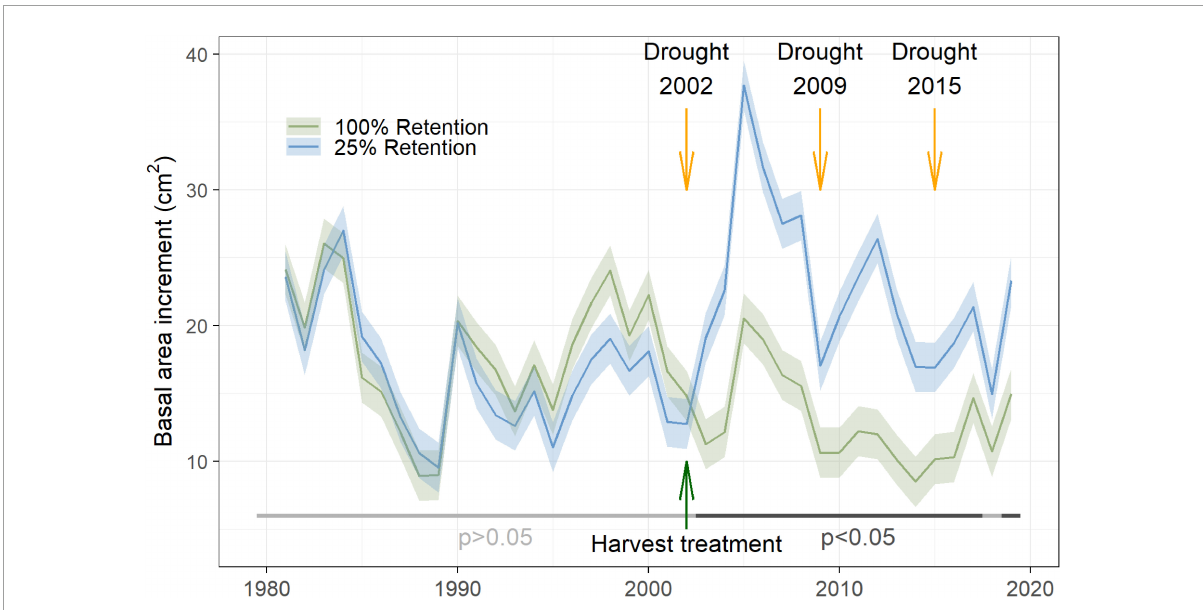
FIGURE4 Timeseries of basal area increments for the no-harvest control (100% retention) and the harvest treatment (25% retention) from 1980 to 2019. The standard error of the mean is indicated with shaded ribbons. A green arrow indicates the harvest year in winter of 2002/2003. Three drought years shortly before (2002), and after the tree removal treatment (2009 and 2015) are indicated with orange arrows. Non-significance of differences in basal area increments is shown by a horizontal line in light grey, while a horizontal line shaded in dark grey indicates significant differences.